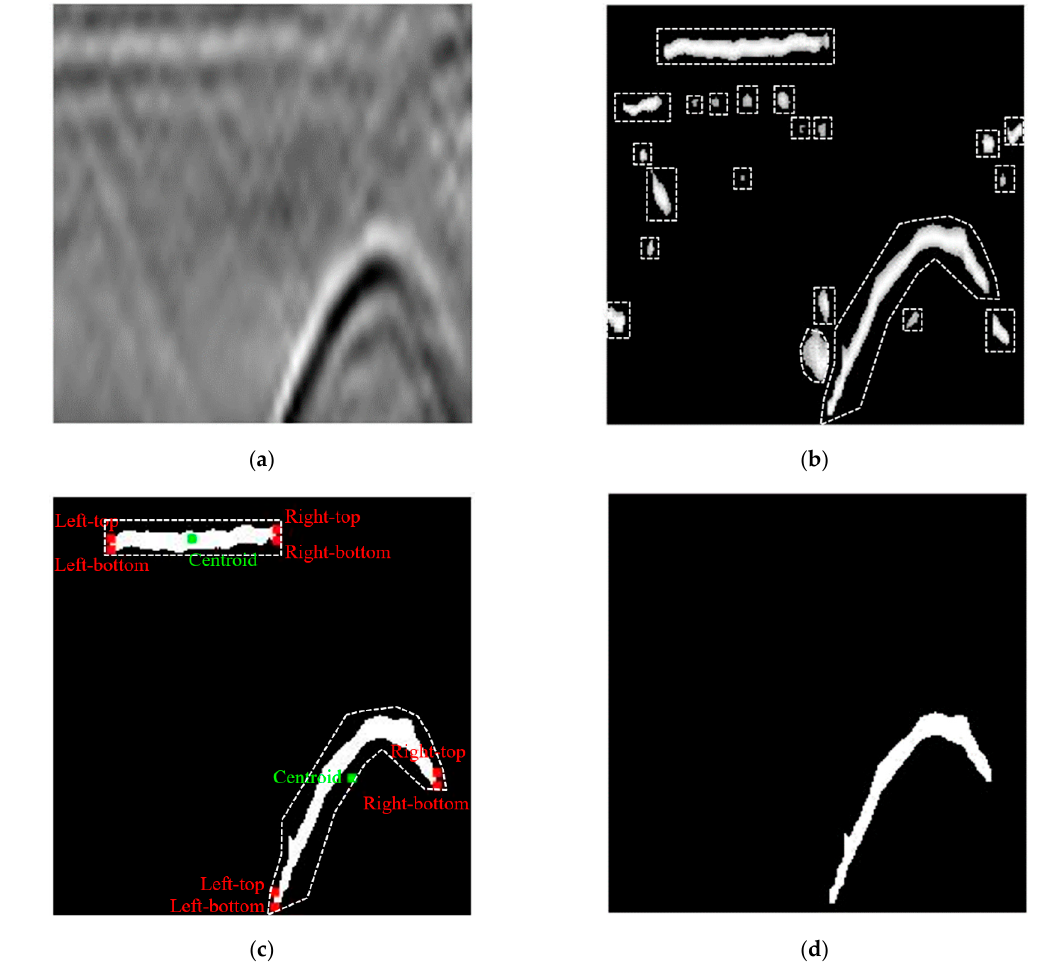
Figure 6. Representative ( a ) SR B-scan image, ( b ) feature extracted image, ( c ) noise removal image, and ( d ) parabola boundary extraction image.